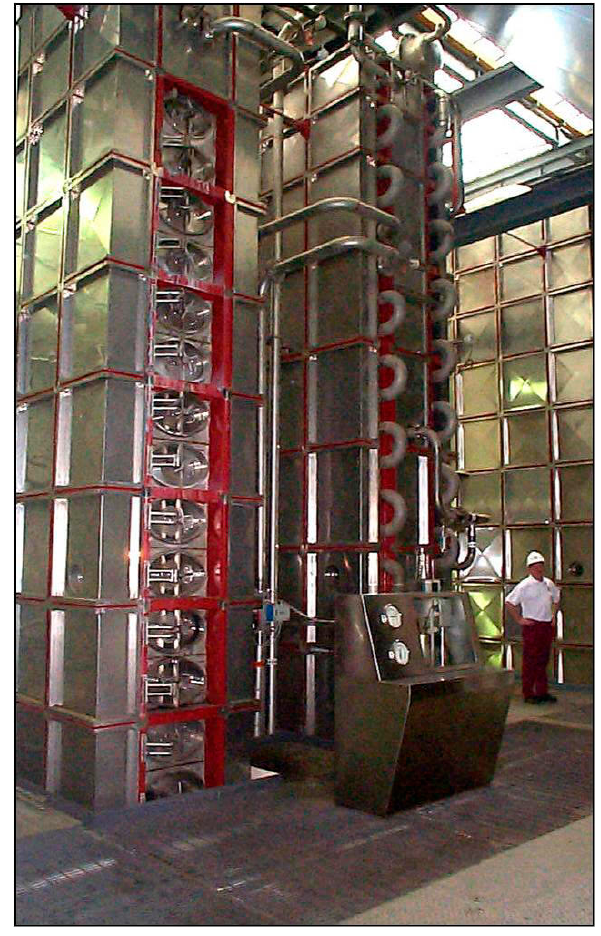
Figure 23. Coffey still employed for the continuous distillation of grain whisky.